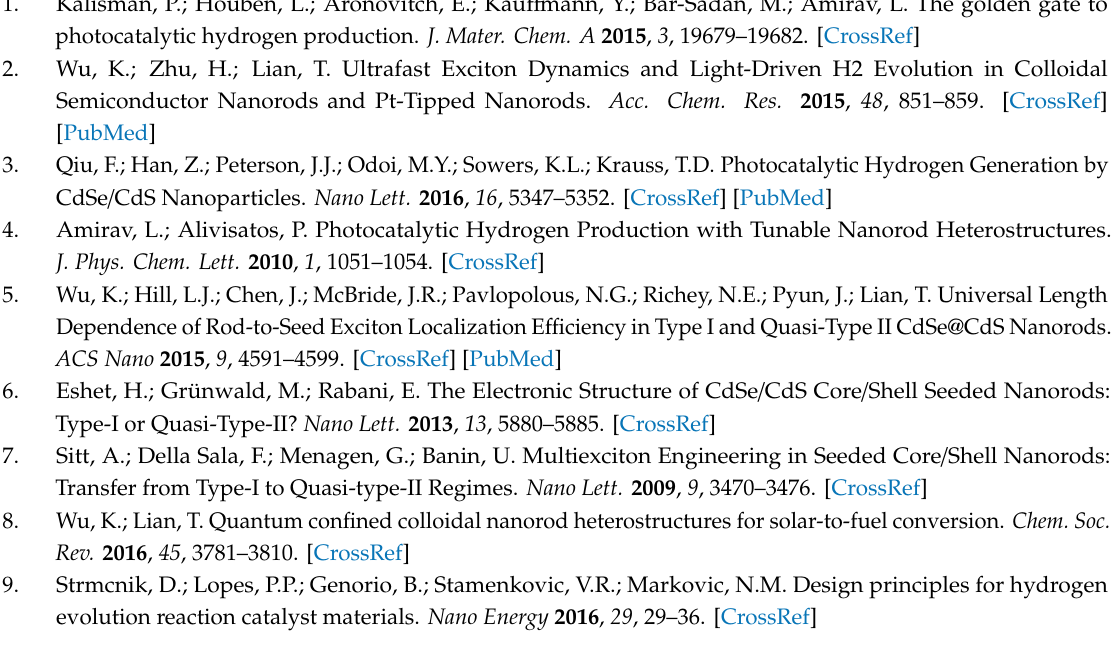
length and (C) and (F) width distribution of the rods. Figure S2. IR-spectra of TOPO and TOPO-NR. Table S1. IR-frequencies of TOPO and TOPO-NR. Figure S3. IR-spectra of MUA and MUA-NR. Table S2. IR-frequencies of MUA and MUA-NR. Figure S4. IR-spectra of HS-PEG and HS-PEG-NR. Table S3. IR-frequencies on HS-PEG and HS-PEG-NR. Figure S5. IR-spectra of DHLA and DHLA-NR. Table S4. IR-frequencies of DHLA and Figure S8. Photoluminescence spectra of NR capped with di ff erent surface ligands normalized to their integrated area. Figure S9. Gaussian fits of steady-state spectra of TOPO-NR. Figure S10. Gaussian fits of steady-state spectra of MUA-NR. Figure S11. Gaussian fits of steady-state spectra of HS-PEG-NR. Figure S12. Gaussian fits of steady-state spectra of DHLA-NR. Figure S13. Gaussian fits of steady-state spectra of DHLA-PEG-NR. Figure S14. Gaussian fits of steady-state spectra of PEI-NR. Table S7. Fitting results for absorption spectra of nanorods with di ff erent surface ligands by five Gaussians. Table S8. Fitting results for line-shape spectra of nanorod photoluminescence with di ff erent surface ligands by two Gaussians. Figure S15. Gaussian fits of steady-state spectra of QDs used as seeds. Figure S16. Photoluminescence spectra of DHLA-NR synthesized under neutral and basic conditions recorded in water. Table S9. Localization and intrinsic radiative recombination e ffi ciencies of the samples investigated, calculated via Equation (1). Figure S17. Transient absorption spectroscopy of TOPO-NR upon 390 nm excitation. Figure S18. Transient absorption spectroscopy of MUA-NR upon 390 nm excitation. Figure S19. Transient absorption spectroscopy of HS-PEG-NR upon 390 nm excitation. Figure S20. Transient absorption spectroscopy of DHLA-NR upon 390 nm excitation. Figure S21. Transient absorption spectroscopy of DHLA-PEG-NR upon 390 nm excitation. Figure S22. Transient absorption spectroscopy of PEI-NR upon 390 nm excitation. Figure S23. Spectroscopic evidence of hole trapping in the spectral region of 600–750 nm recorded for TOPO-NR in toluene. Figure S24. Relative contribution of DAS( τ n) to the total CdS bleach